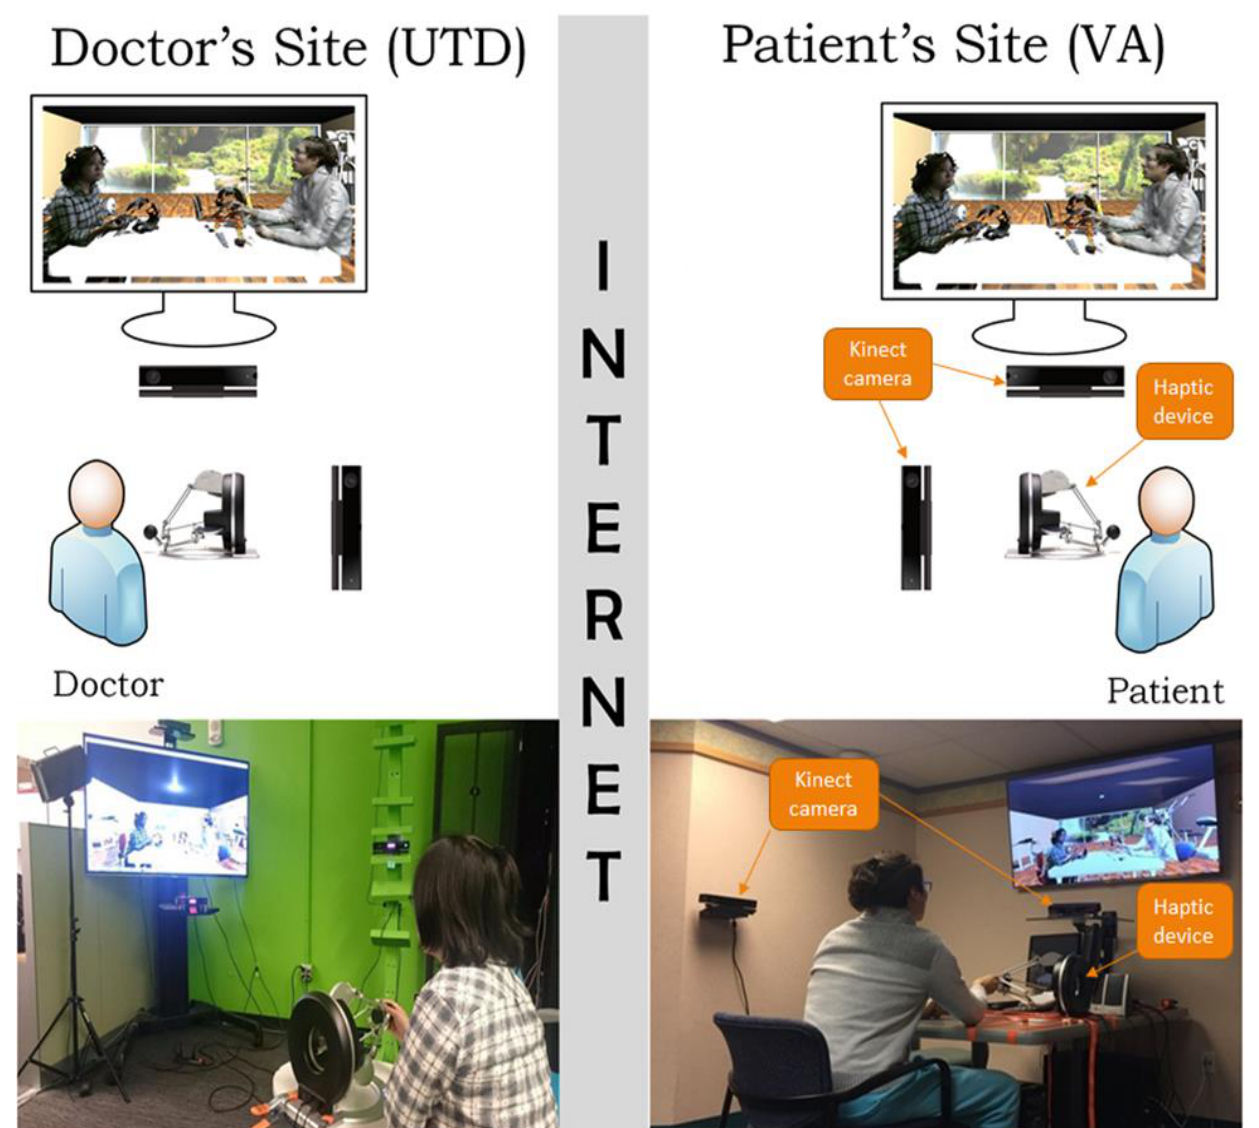
Figure 1. Each site was equipped with two Xbox Kinect RGB-D cameras (arranged orthogonal to user), one haptic controller (fastened to the desk), a 3D-capable TV, active 3D-glasses, and a computer. The computers were networked via the internet, and audio, video, and force data were transmitted in real-time between the two